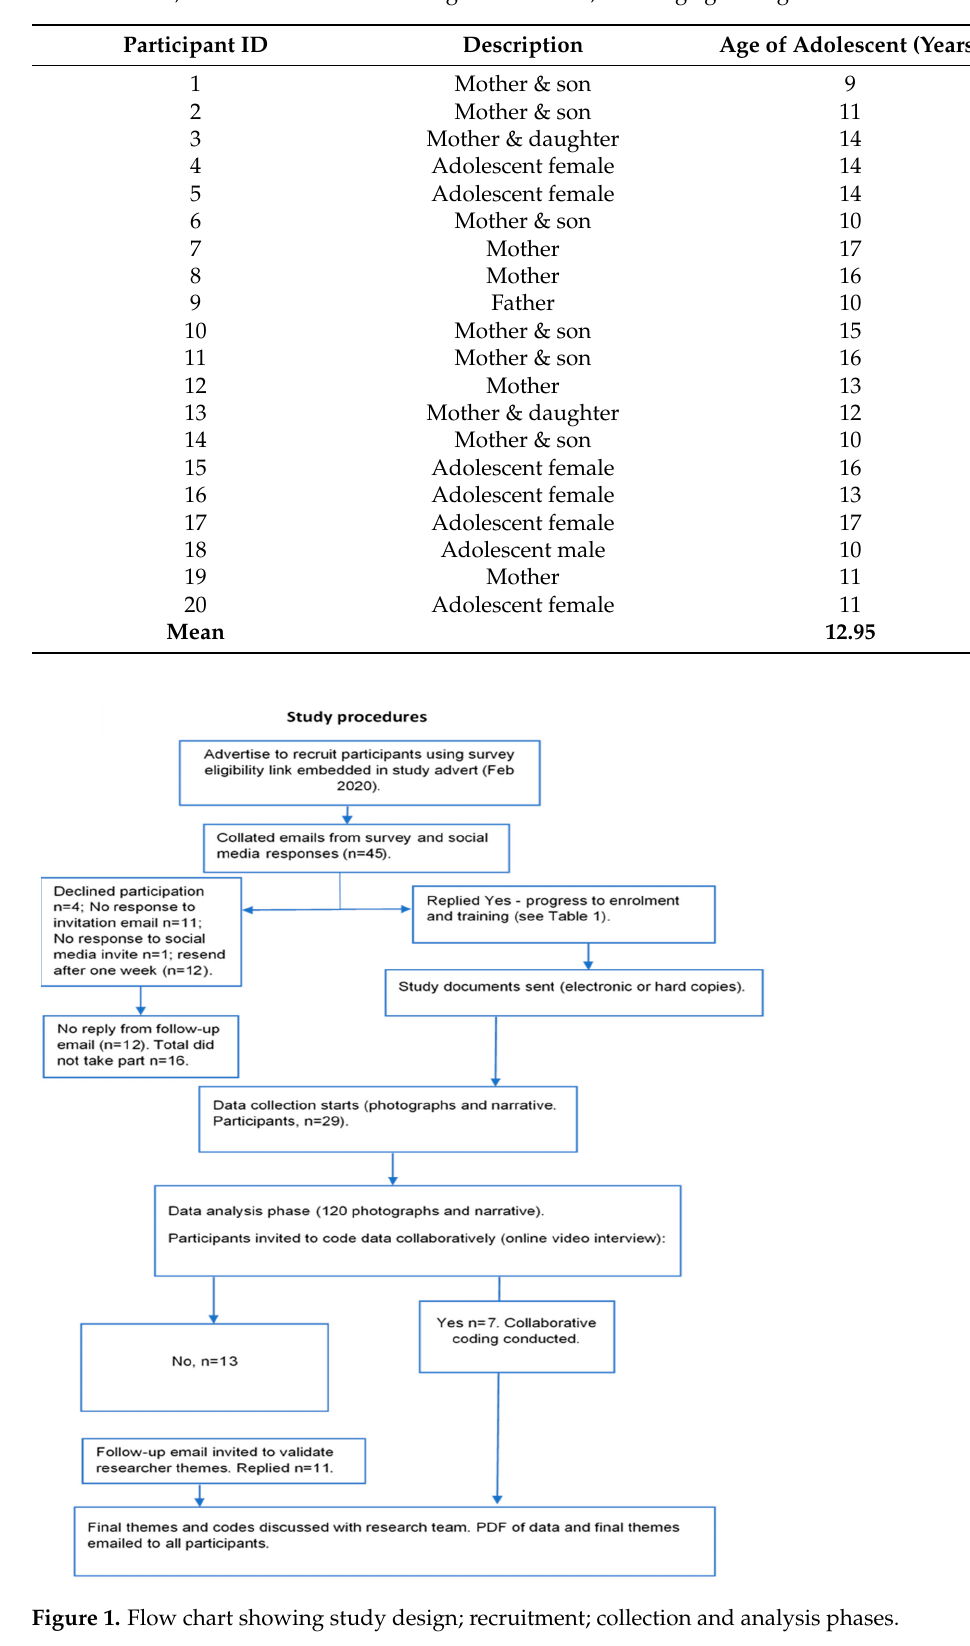
Table 1. Participant descriptions showing variations of adolescent and parents acting in partnership to submit data, and adolescents submitting on their own, showing age and gender.